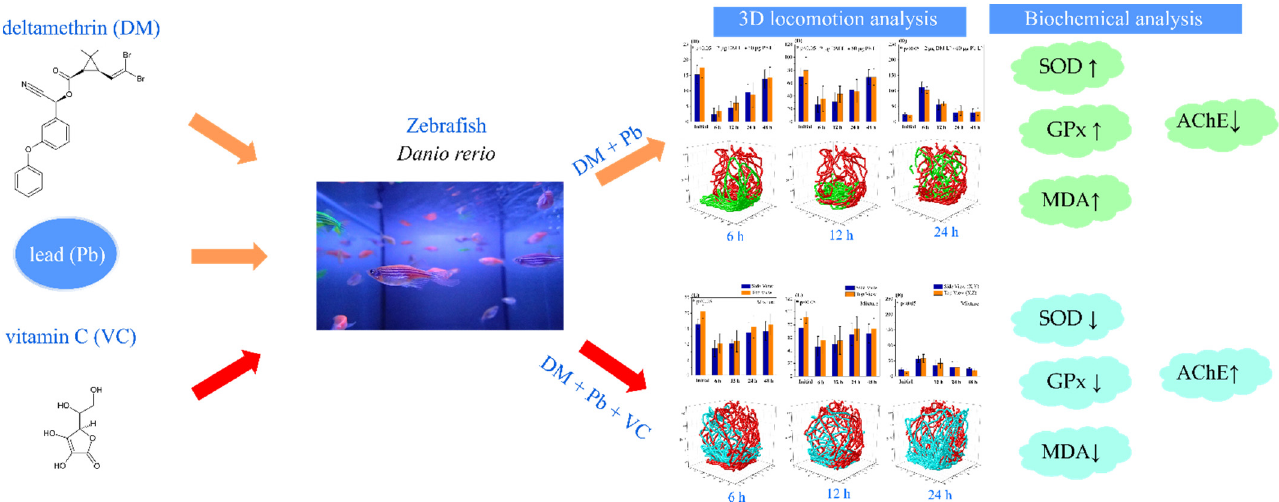
Figure 4. Schematic presentation of the present study. The adverse effects of exposure to environmental pollutants, such as lead and deltamethrin mixture, and the efficiency of vitamin C in alleviation of their toxicity in juvenile zebrafish were assessed. The exposure to a heavy metal/pyrethroid mixture induced behavioral abnormalities and oxidative stress in fish. In addition, the efficiency of vitamin C in alleviation of toxicity caused by chemicals exposure was demonstrated.